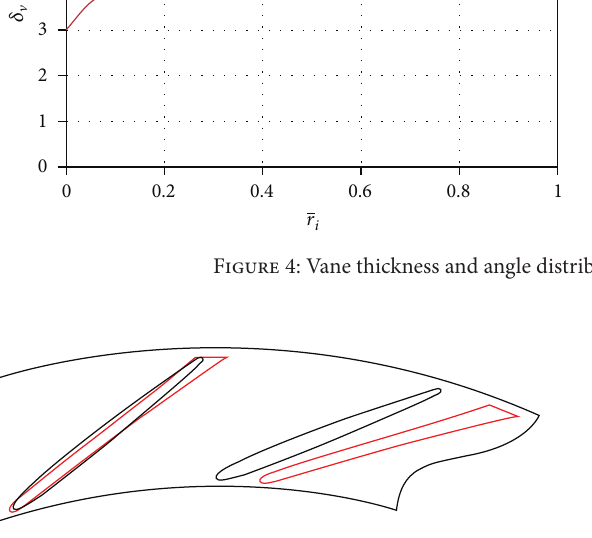
Figure 5: The comparison between the base VD vane channel (black) and designed CD vane channel (red).